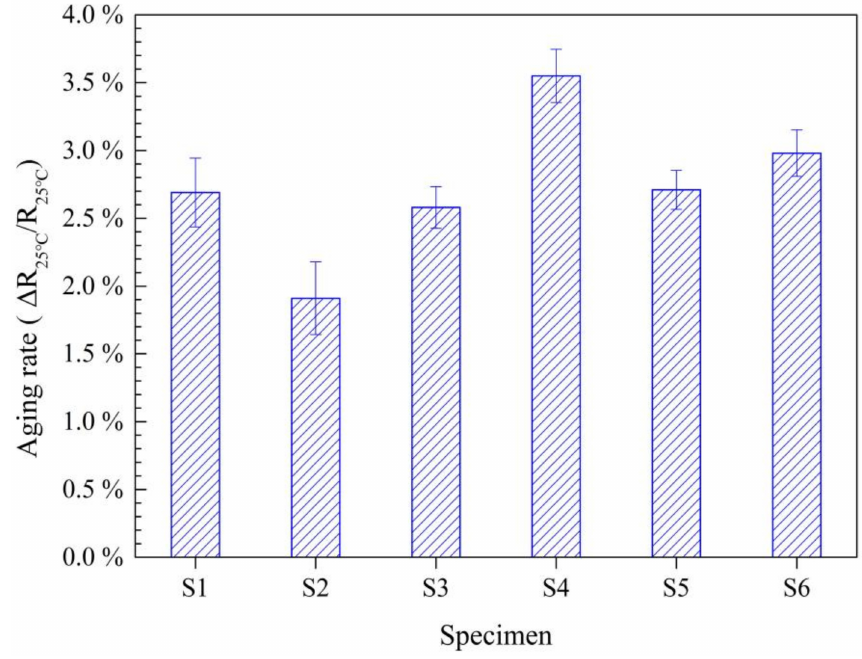
Figure 11. The aging rates of the sintered samples of